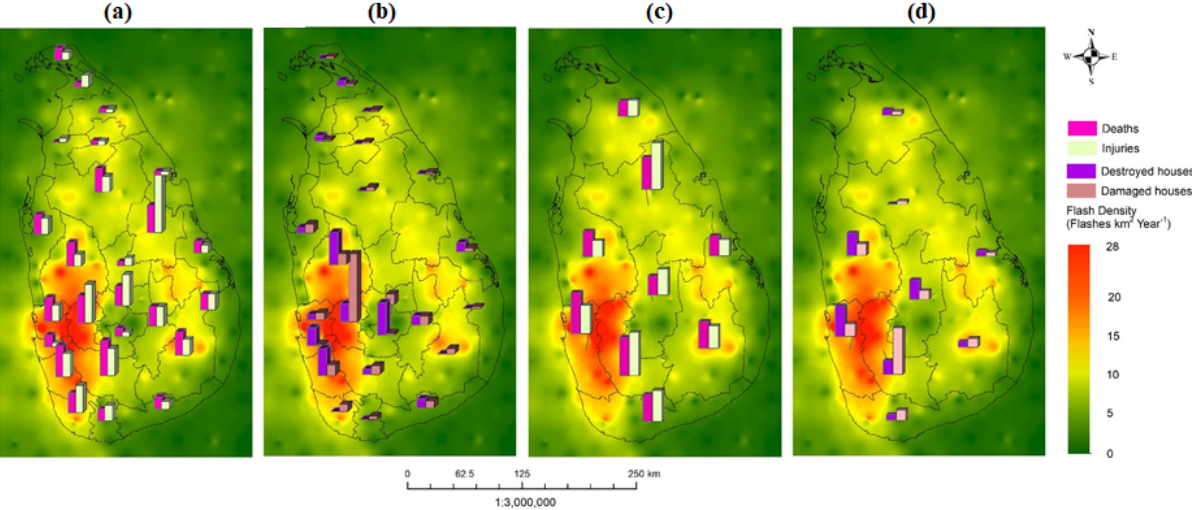
Figure 10. Annual variation of lightning flash density with the recorded lightning accidents (in %) in Sri Lanka, from 1974 to 2019: ( a ) deaths and injuries according to districts; ( b ) property damage according to districts; ( c ) deaths and injuries according to provinces; ( d ) property damage according to provinces.